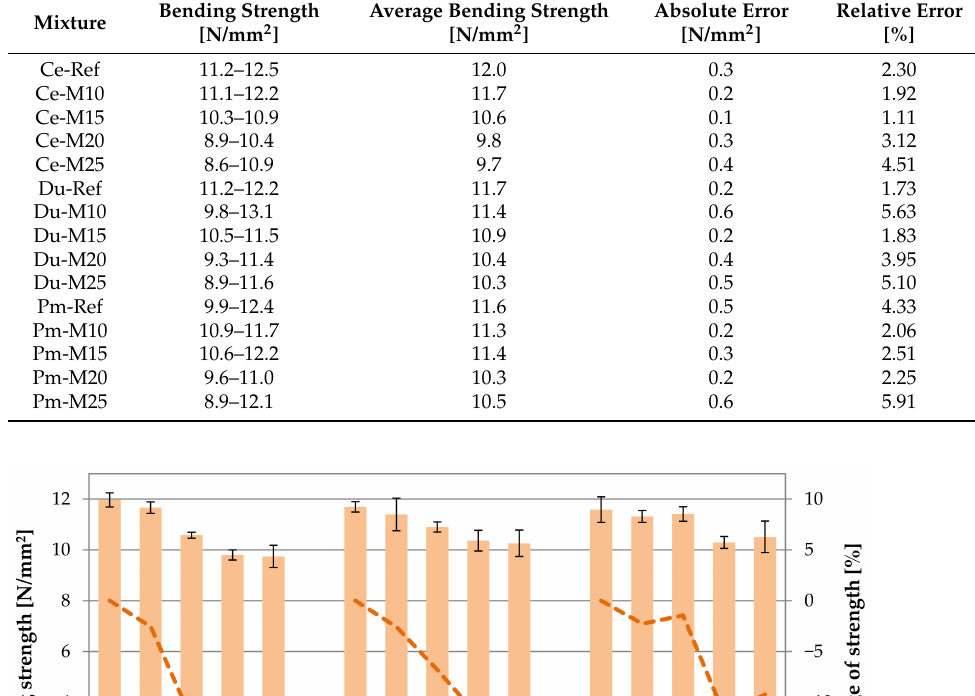
Table 4. Results of bending strength testing of modified cement-bonded particleboards.